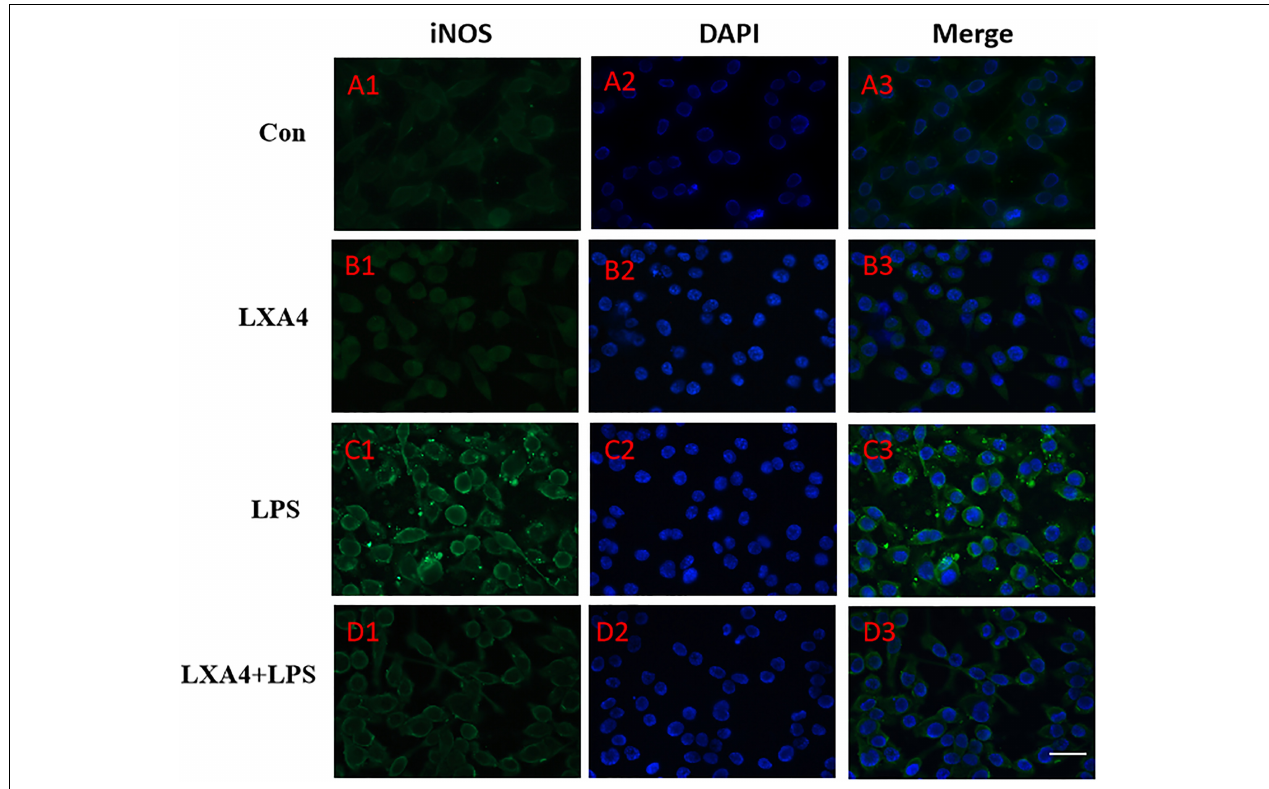
FIGURE 4 | Immunofluorescence images showing the BV2 microglia after LPS stimulates which were labeled with iNOS antibody, with LXA4, the expression of iNOS is decreased. Green fluorescence indicated iNOS positive cells, while blue fluorescence indicated DAPI-labeled nuclei. Scale bar: 20 µ